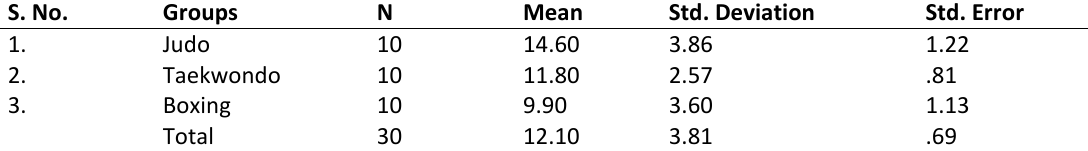
Table 11. Descriptive analysis among judo, taekwondo and boxing players on the sub-parameter team ritual S. No.